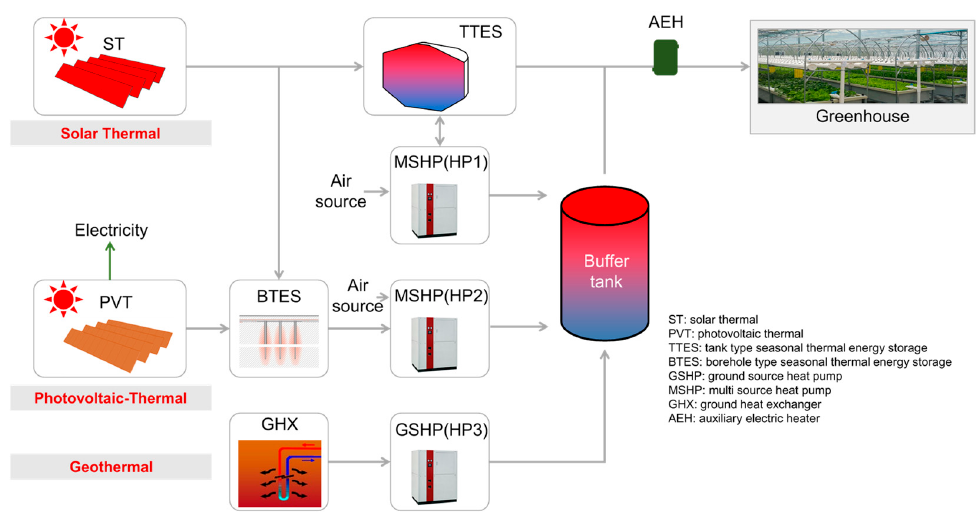
Figure 2. Configuration of the proposed system.